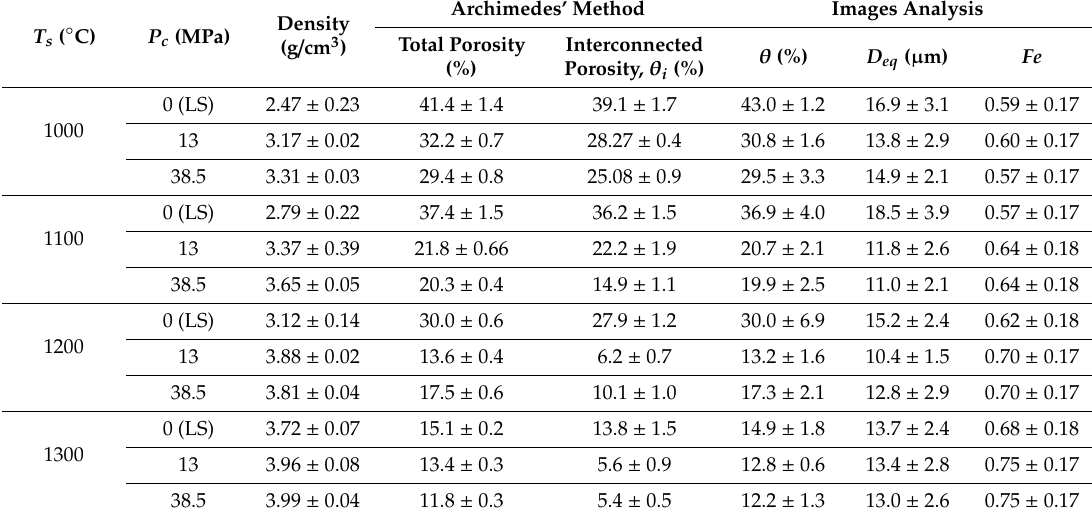
Figure 2. Optical images of the porous samples obtained with different compaction pressure and sintering temperature. Common scale bar. Table 1. Influence of processing conditions on the characteristics of the obtained porosity.